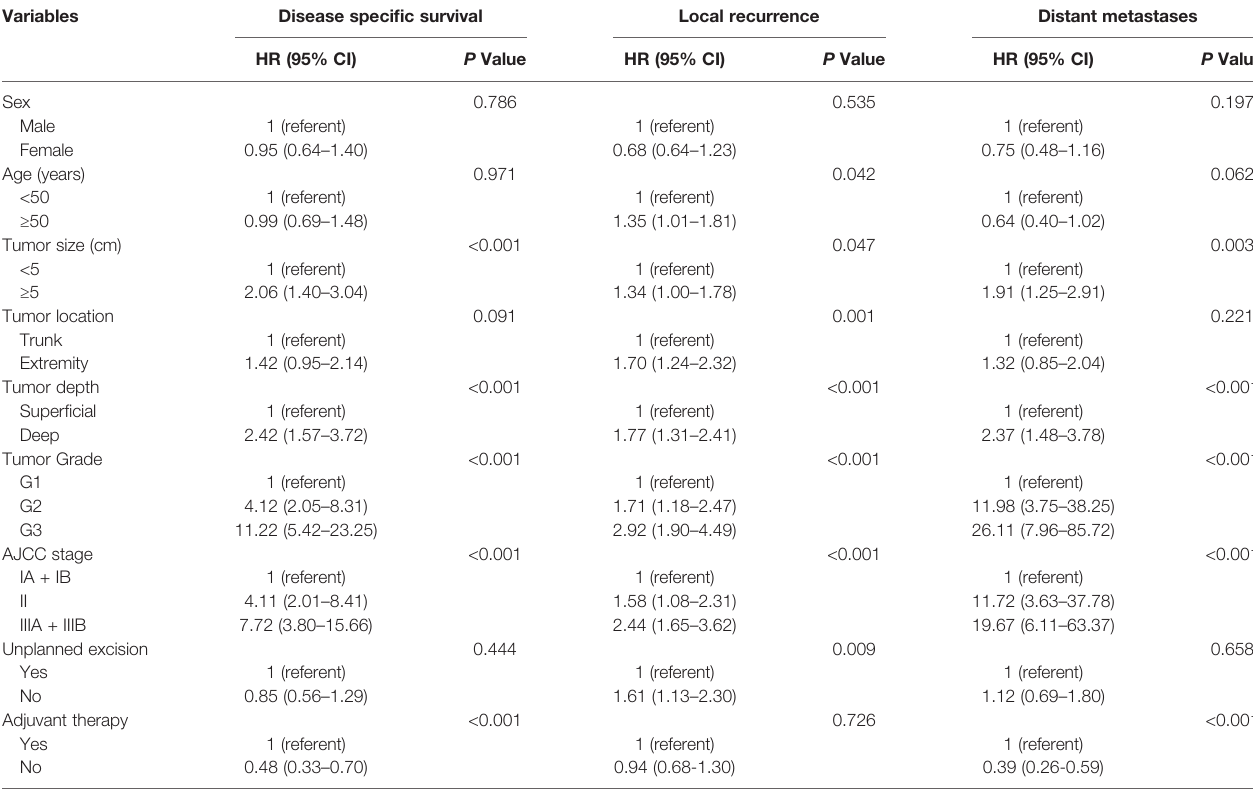
TABLE 3 | Univariate analyses of variables for disease speci fi c survival, local recurrence and distant metastases (unmatched complete datasets).